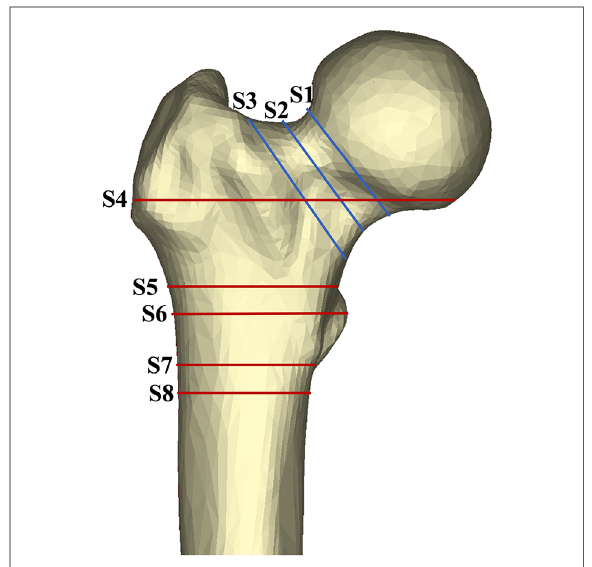
FIGURE 2 Area of exploration in proximal femoral region. The femoral neck was divided by axial S1 – 3 (sections at the subcephalic, middle, and bottom sites of the femoral neck, respectively). Similarly, the shaft region was divided by S4 – 8 (sections at 20 mm above the upper edge of the femoral lesser trochanter, the upper edge of the femoral lesser trochanter, the vertex of the femoral lesser trochanter, the lower edge of the femoral lesser trochanter, and the 20 mm below the vertex of the femoral lesser trochanter, respectively).